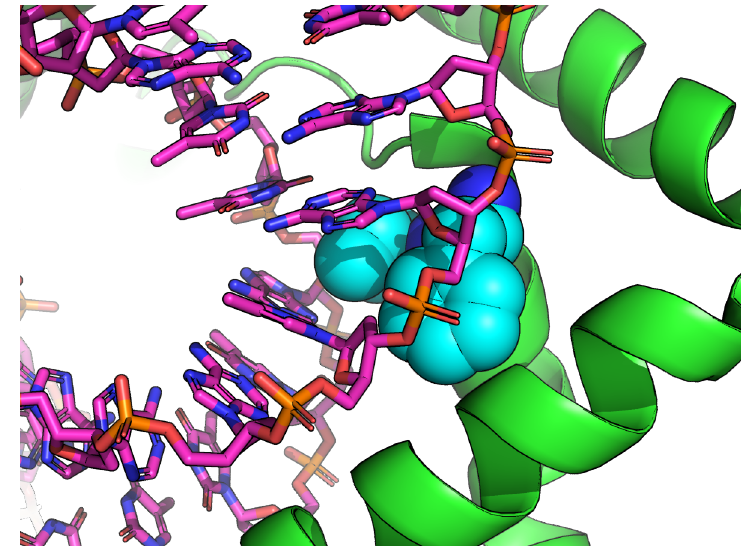
Figure 7. The non-intercalating interaction in the structure 5JH0. Bulky, hydrophobic residues (Phe, Ile) are shown in teal. Visualized using PyMOL-1.7.2.1 [27].